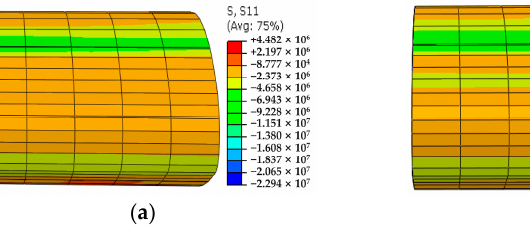
( c ) Figure 14. The horizontal stress of the temporary support in different conditions (unit: Pa): ( a ) Condition 1; ( b ) Condition 2; and ( c ) Condition 3.